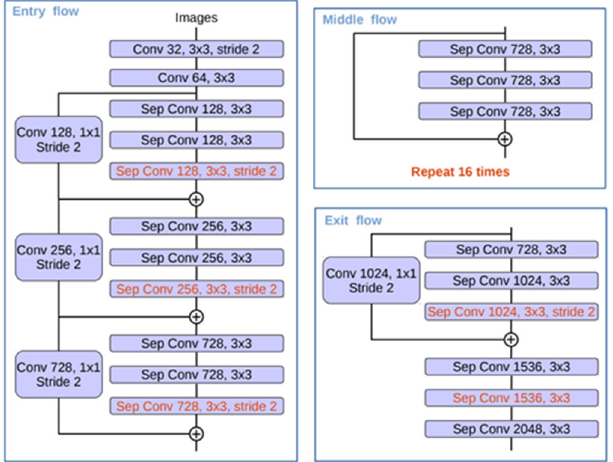
Figure 5. The improved Xception network.